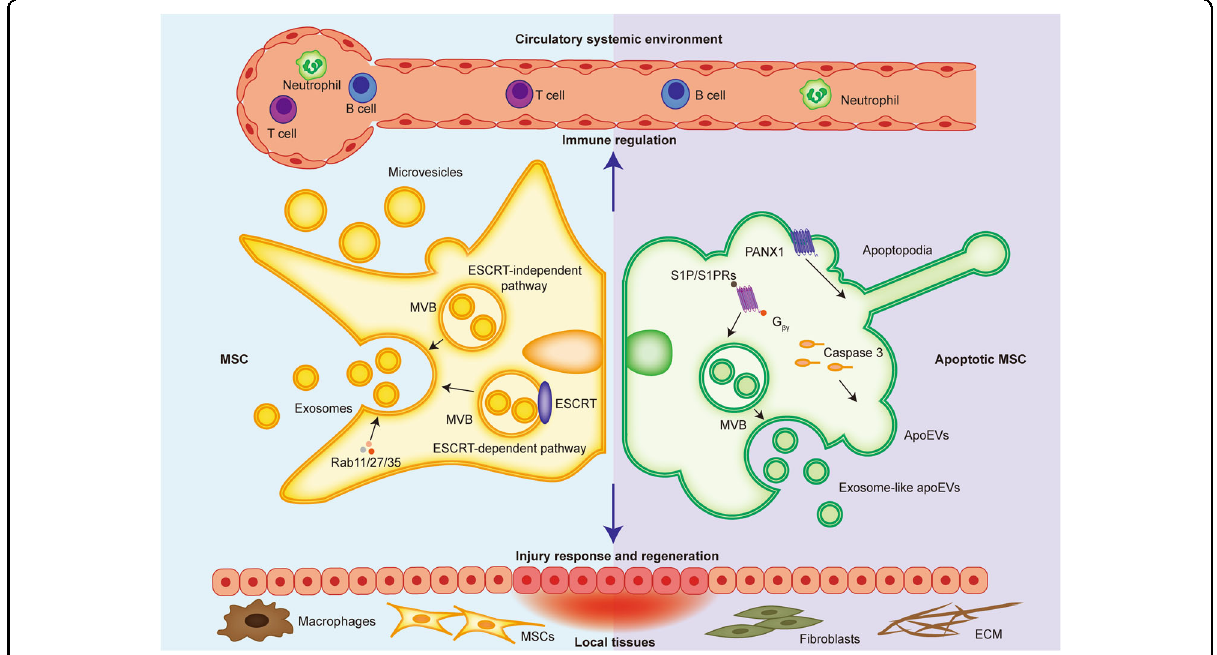
Fig. 2 Generation and functionality of EVs from normal and apoptotic cells. From normal cells, exosomes are formed through exocytosis of endosomal membrane based on ESCRT-dependent and -independent mechanisms, which subsequently secrete exosomes via Rab11/27/35. Microvesicles are shed from the plasma membrane. In contrast, apoEVs are released from apoptotic cells based on multiple mechanisms including (S1P)/S1PRs- and Caspase 3-depended apoEV release as well as PANX1-controlled apoptopodia formation. On the one hand, EVs and apoEVs modulate immune responses in circulatory system. On the other hand, they are attributed to injury response and regeneration of local